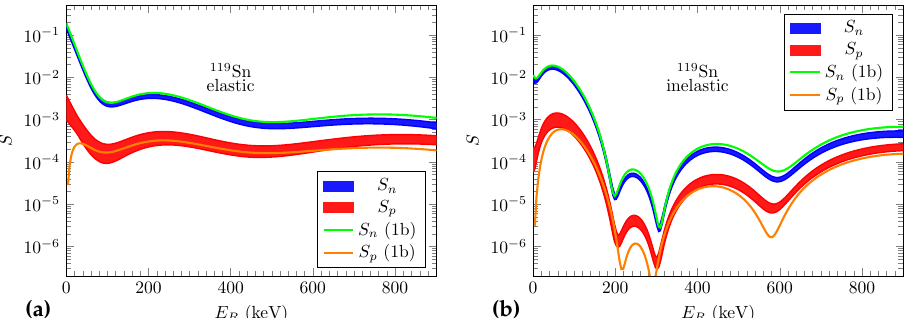
Figure 2. Structure functions of nucleus 119 Sn: ( a ) Left panel shows neutron-only and proton-only structure functions in the case of elastic scattering (nucleus remains in the ground state 1/2 + ). ( b ) Right panel shows neutron-only and proton-only structure functions in the case of inelastic scattering (nucleus excites to the first excited state 3/2 + ). S n , p (1b) are with one-body currents only.